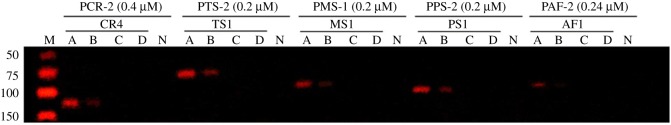
Sensitivity test for five specific primer sets. The concentration of template DNA from lane A to lane D was 10, 1, 0.1 and 0.01 ng µl−1.